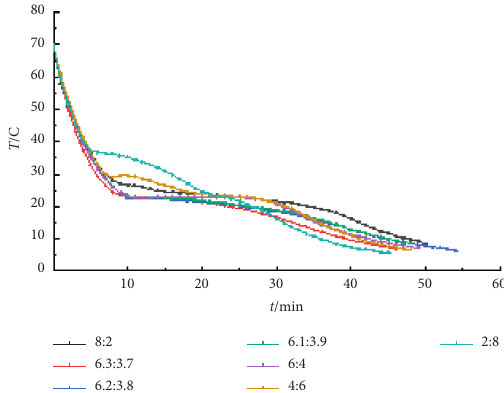
Figure 3: Step cooling curves of binary eutectic TD-MA and LA at different mass ratios.